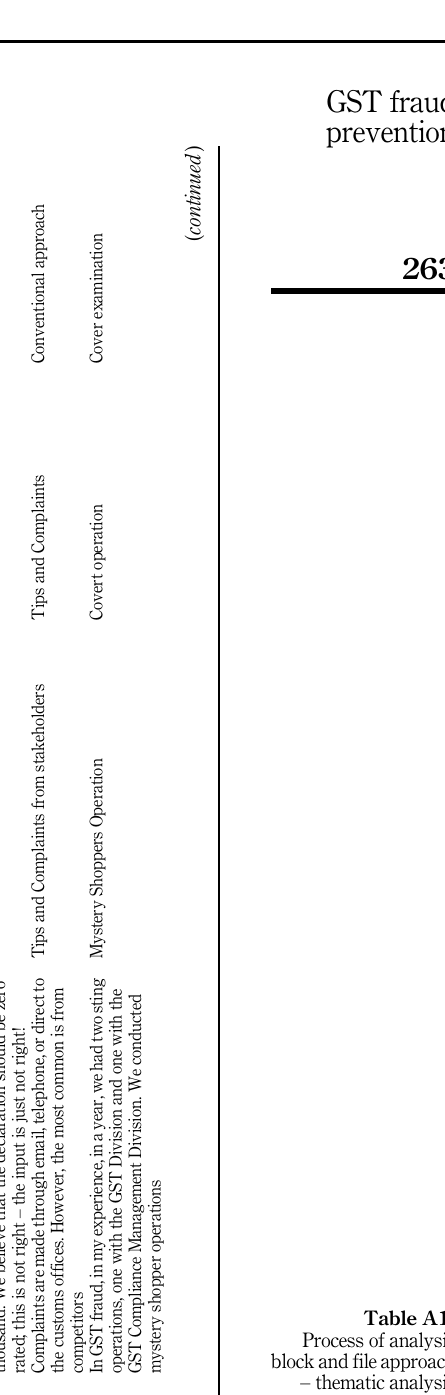
Table A1. Process of analysis block and file approach – thematic